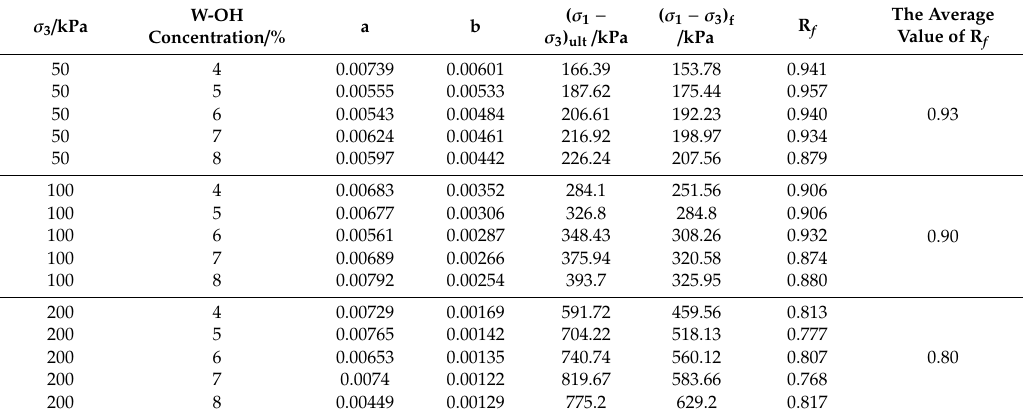
Table 3. Demonstration of the fitted parameters based on the Duncan – Zhang model.